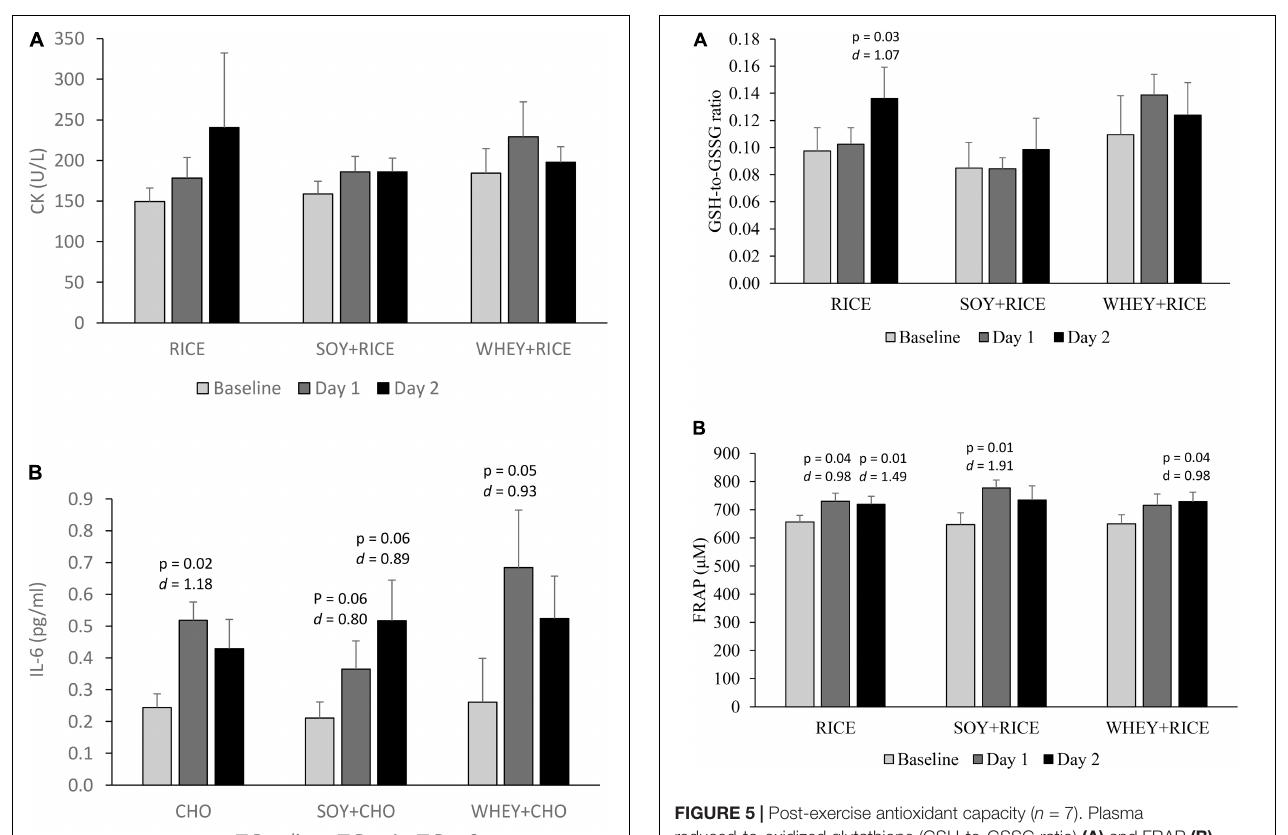
and Day 2 was observed in the RICE trial. The protein content of SOY + RICE was only half of the WHEY + RICE drink ( Table 1 ).